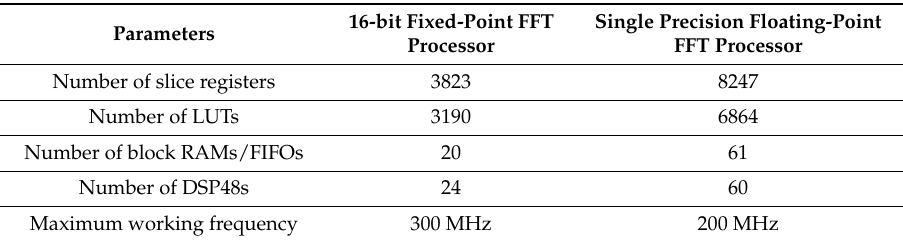
Table 7. Resource comparison between 16,384-point fixed-point FFT processor and single precision floating-point FFT processor.